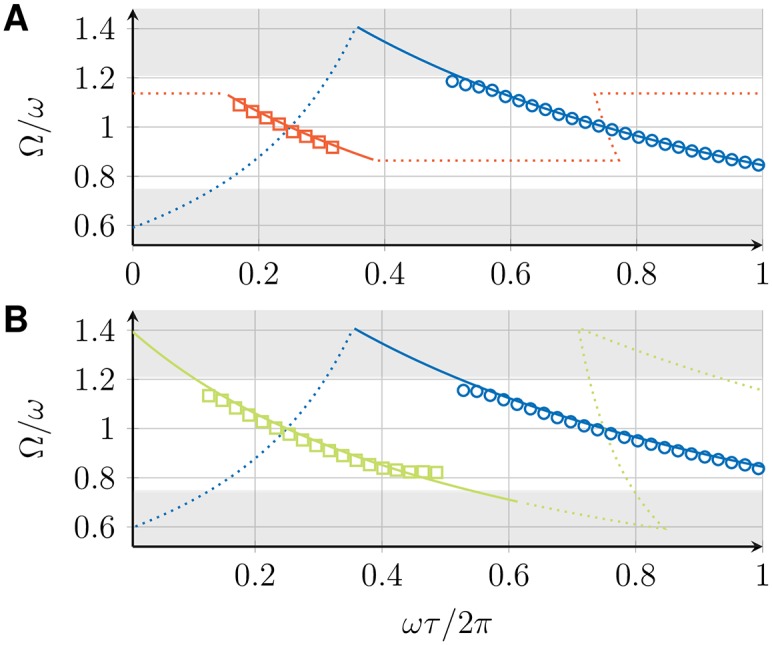
Experimental measurements of the collective frequencies Ω for nine coupled DPLLs.Collective frequency Ω of different synchronized states for a square lattice of 3 × 3 mutually coupled DPLLs as a function of the transmission delay τ. (A) In-phase synchronized state (blue circles) and all combinations of m1-m2-twist synchronized states with m1, m2 ≠ 0 (red squares) for a system with periodic boundary conditions. (B) In-phase synchronized state (blue circles) and checkerboard synchronized state (green squares) for a system with open boundary conditions. The shaded areas display the system’s clipping region as shown in Fig 8. Color code as in Fig 10.